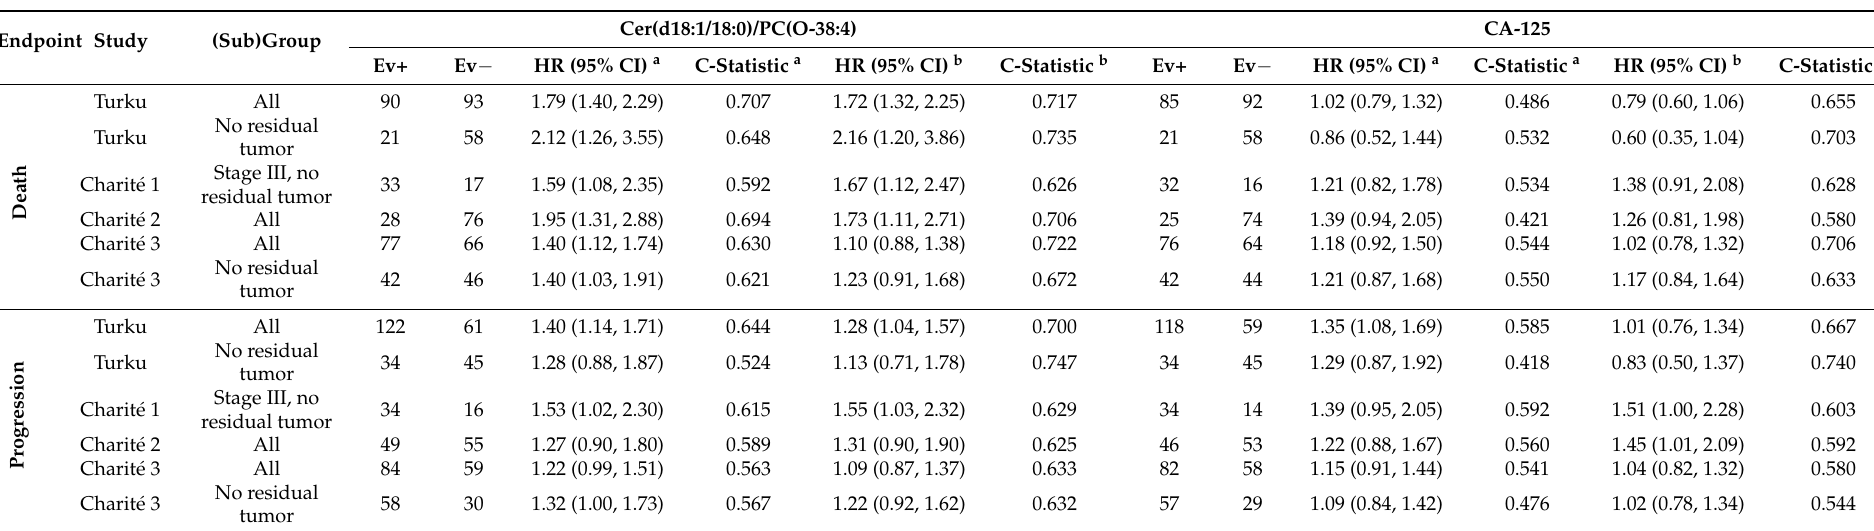
Table 2. Hazard ratios of the two-lipid signature and cancer antigen 125 (CA-125) for overall and progression-free